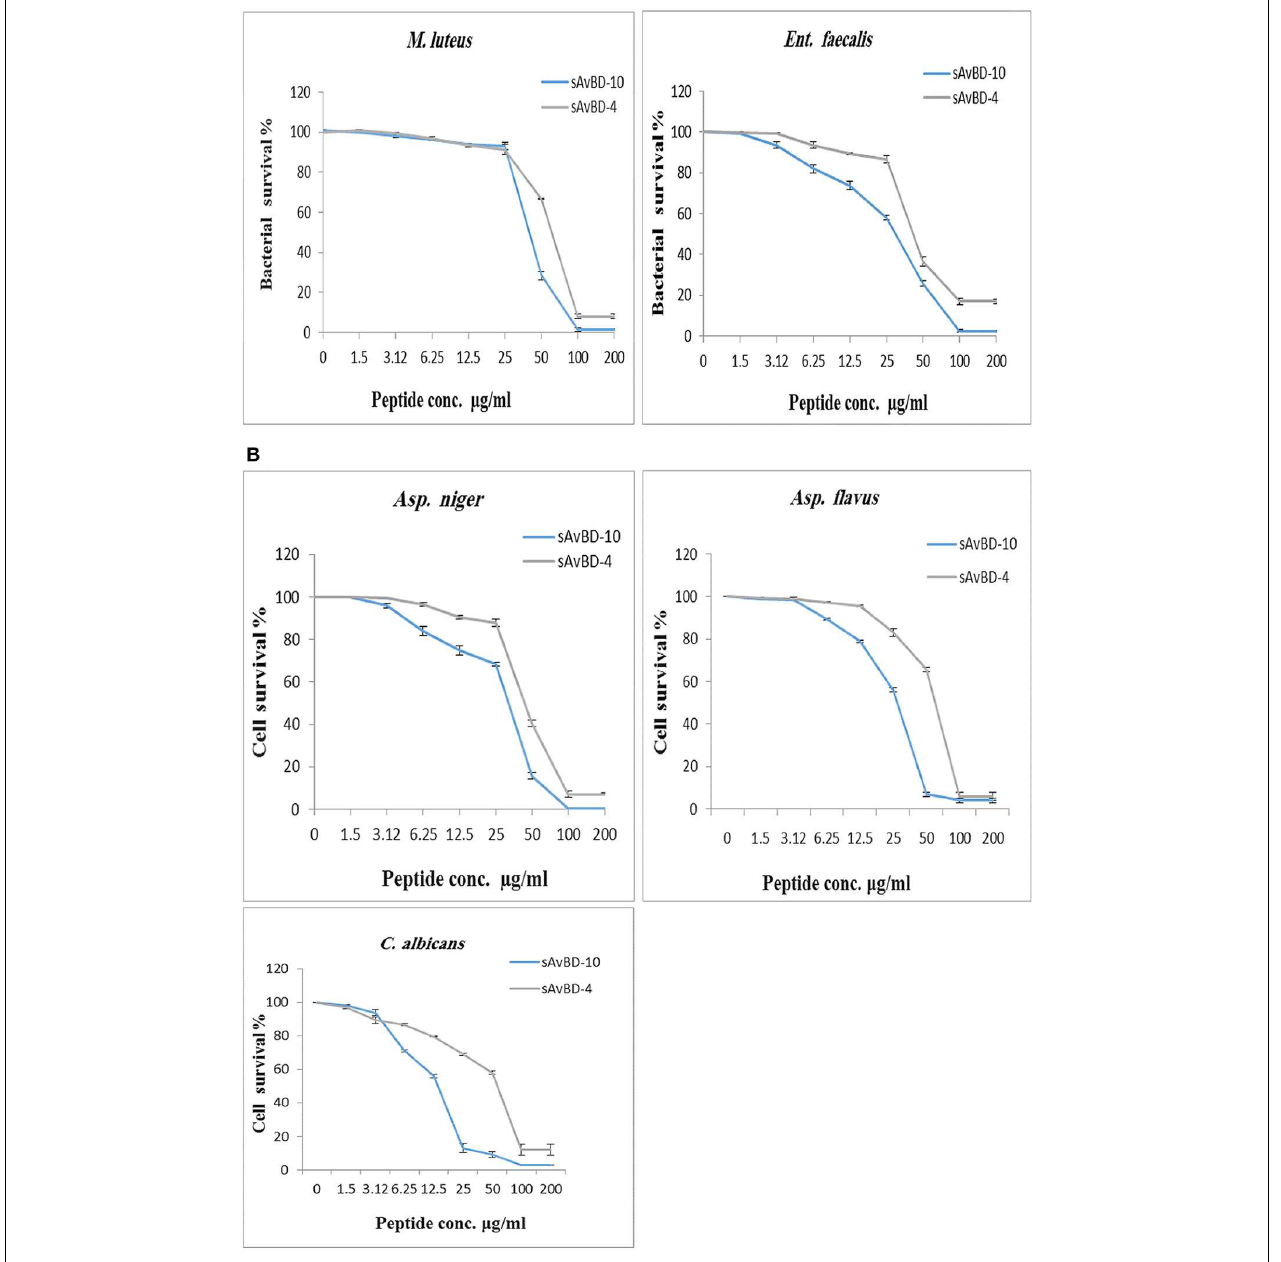
FIGURE 1 | Antimicrobial activities of synthetic chicken β -defensin-4 and 10-derived peptide (sAvBD) against (A) bacteria and (B) Fungal species. All assays were performed in three independent experiments and each point is the mean ± SE, ( P < 0 . 002